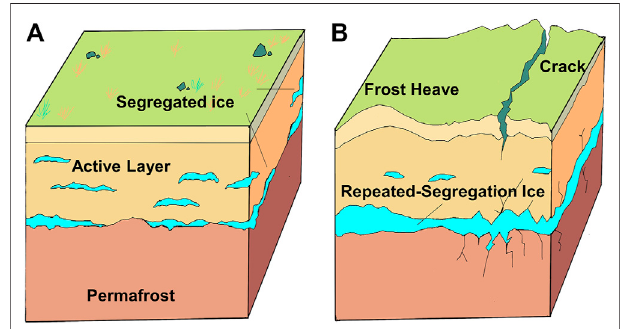
FIGURE6| Aschematicdiagramoflandformsinpermafrostregions. (A) Segregated ice forms in the active layer at fi rst, and the ice lens at the permafrost table is preserved after a freeze-thaw cycle. (B) Under a cooling climate, the permafrost table is raised, and the accumulation of segregated ice forms massive repeated-segregation ice, causing frost heave and frost crack.